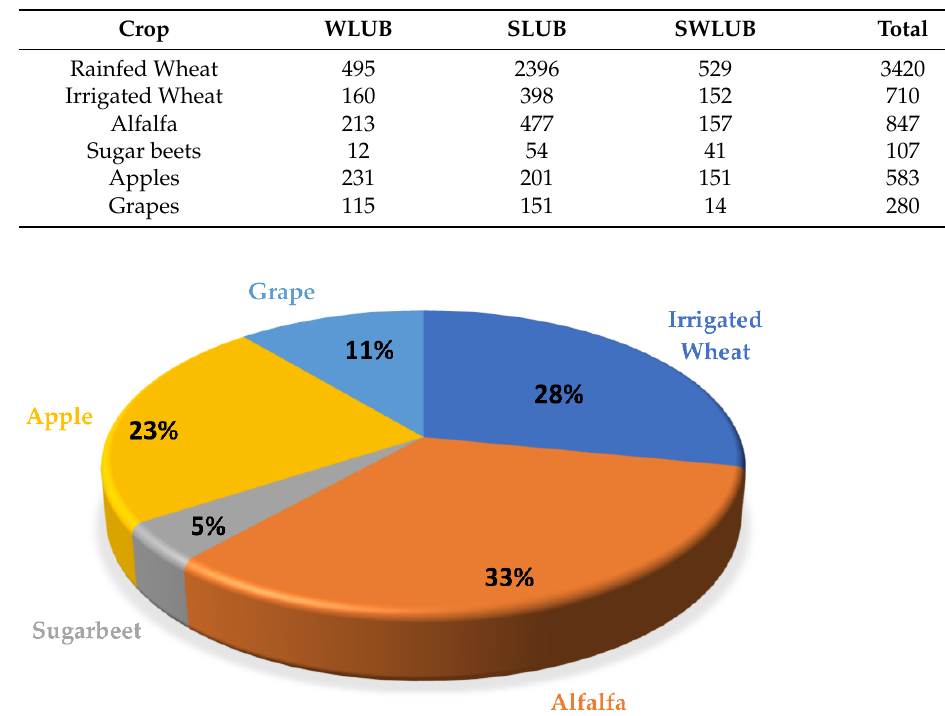
Figure 2. An overview of the selected irrigated crops in LUB.